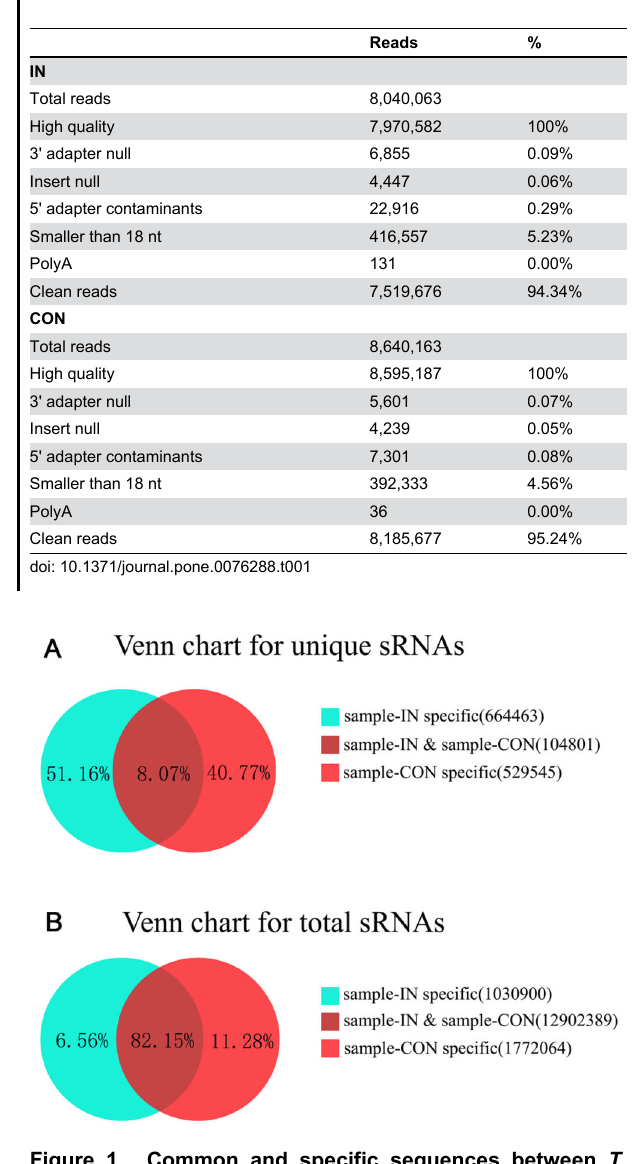
Figure 1. Common and specific sequences between